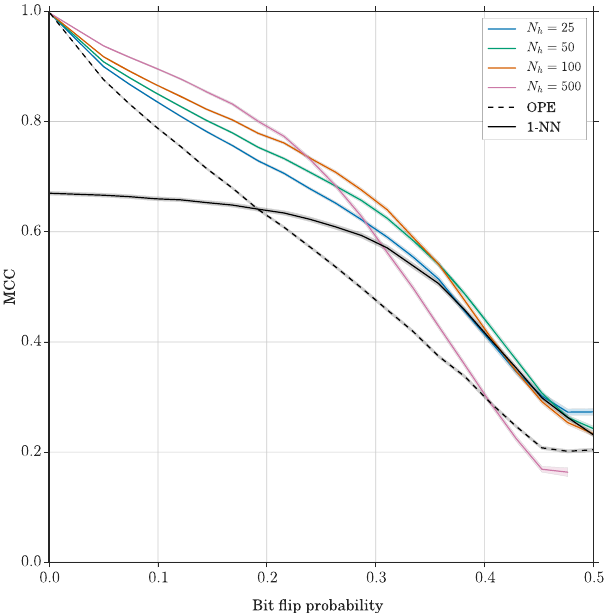
FIG. 8. Average denoising performance for reconstruction from bit-flip errors on binary MNIST over the probability of a bit to be flipped. Denoising via inference on the binary-binary RBM is denoised by the varying numbers of hidden units ( N h ¼ f 25 ; 50 ; 100 ; 500 g ). Also shown as baseline comparisons are the OPE given the empirical factorized magnetizations at each site (dashed black line) and a 1-NN matching from the training set (solid black line). All experiments are run over the same 1000 data samples drawn from the held-out test set and compared using the MCC. Binary estimates are obtained for the OPE and TAP inferred estimates by rounding the resulting